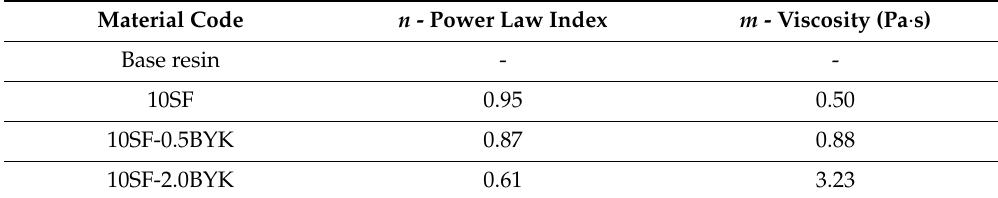
Table 3. Yield stress predictions using the Herschel–Bulkley model (Equation (7)).